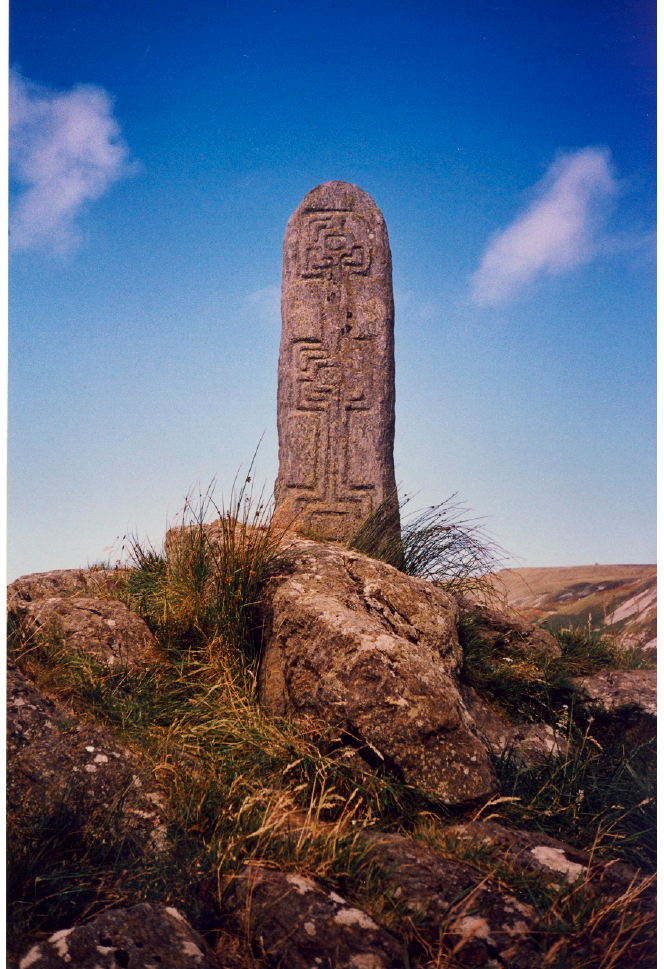
Figure 9. An upright pillar marking Station 2 on the pilgrimage route in Glencolumcille. A stone may also be connected with a saint if it bears some imprints, 28 believed to be the marks of the saint’s: feet, hands, knees, elbows, chin, head or bottom. The saint was believed to have stood on it, rested his/her hands, elbows, chin on it, knelt on it or used it as a pillow. Some stones were blessed by the saint. The stone on the seashore near Kilrush (Co. Clare), reputedly bearing the prints of St. Senan’s knees, was revered by taking off the hat and bowing, accompanied by a prayer. Bowing and praying were also performed while walking around a large stone in the River Roe at Dungiven (Co. Derry). On Inis Cathaigh 29 (Co. Clare) all stones were attributed to St. Senan and therefore bestowed with